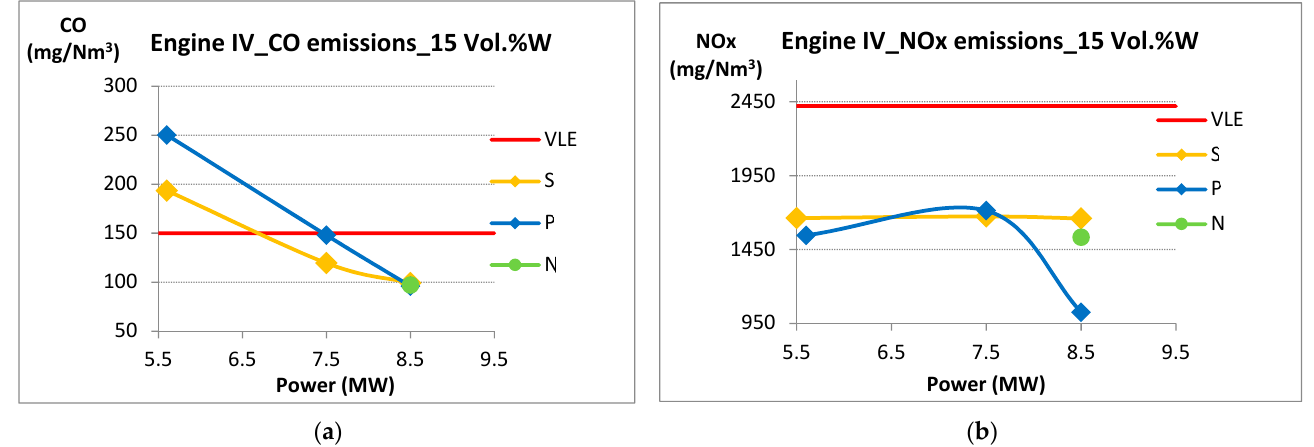
mg/Nm 3 in the P system. CO emissions are lower in system P on engine VI and NOx emis- sions are lower in engine IV system P. sions are lower in engine IV system P.